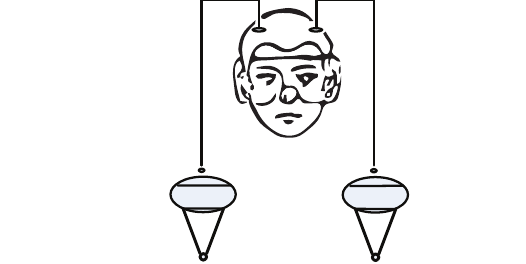
Fig. 2. One of the possible schemes of a 3D system with disparate